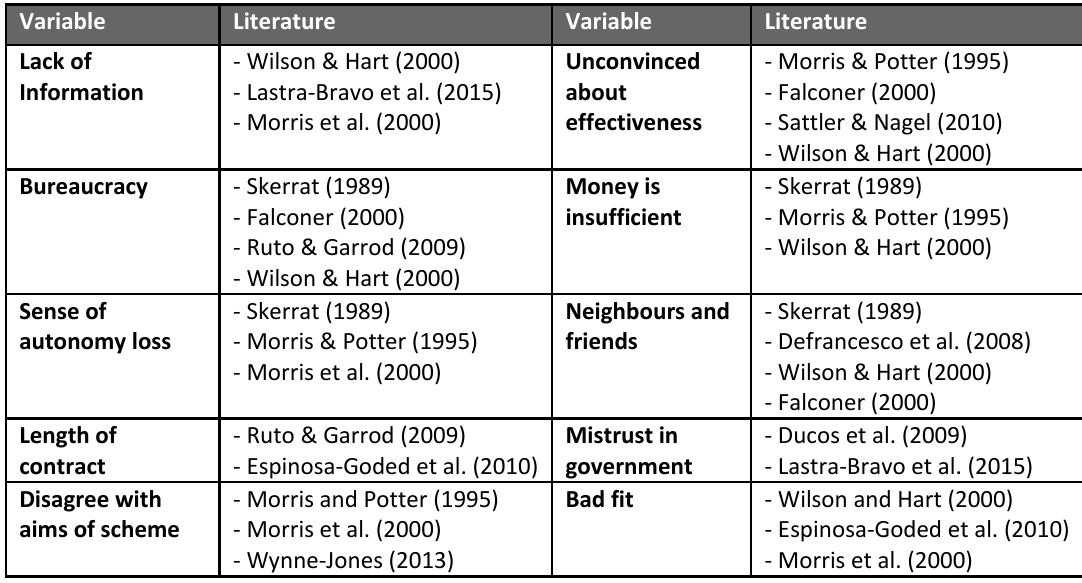
Unconvinced about